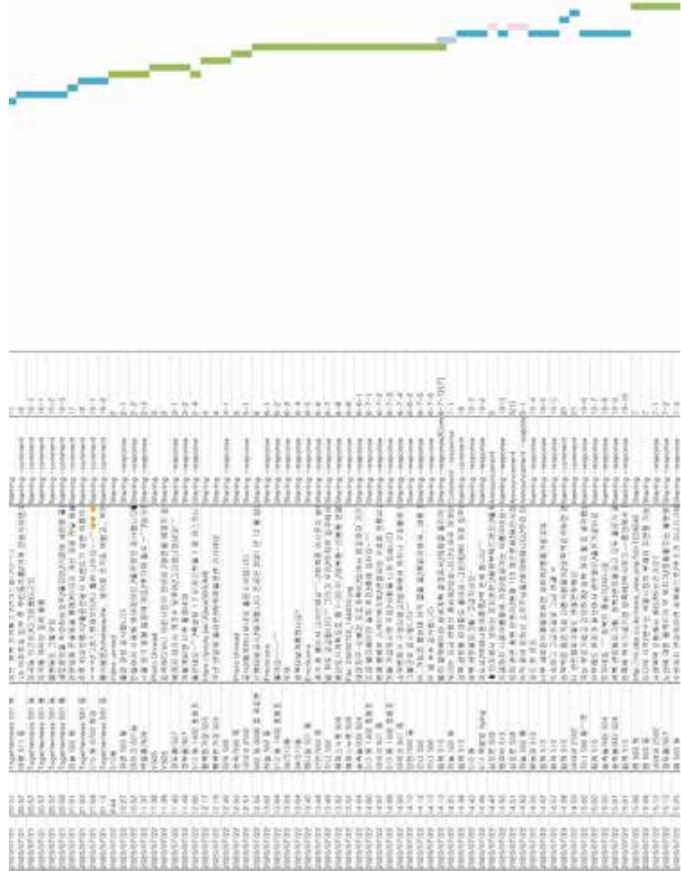
Figure 1: Colour-coded messages disclose multiple yet consistent threads of narratives arising amongst local residents in an instant messaging app. The upper and lower diagrams are different parts along the timeline of the same horizontal diagram. Source: Jen Yoohyun